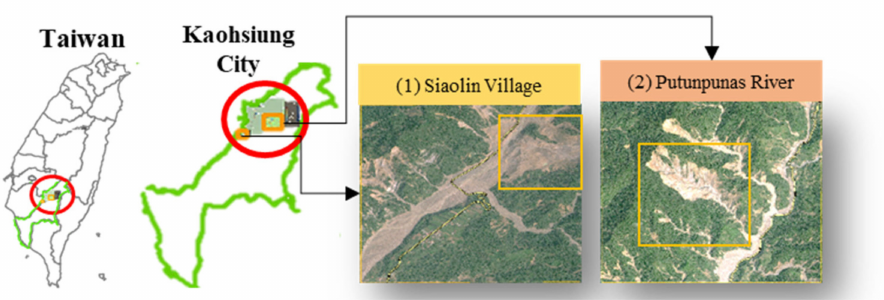
Figure 3. Geographical locations of experimental areas—(1) Siaolin village; (2) Putunpunas River. The observation time of the spatial factors ranged from hours to years. For establishing a common timescale, a year was deemed the basis of unit time, and the observed data time was a total of four years (from 2007 to 2010). The 14 spatial factors used were the elevation, slope, aspect, terrain roughness, profile curvature, vegetation index, annual displacement velocity gradient of InSAR, water distance, road distance, fault distance, rock mass strength, folds, dip slopes, and an annual rainfall, as shown in Figure 4.